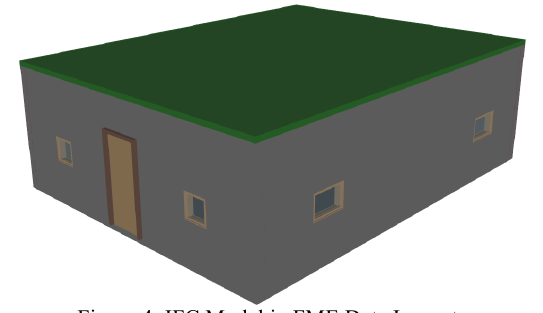
Figure 4: IFC Model in FME Data Inspector